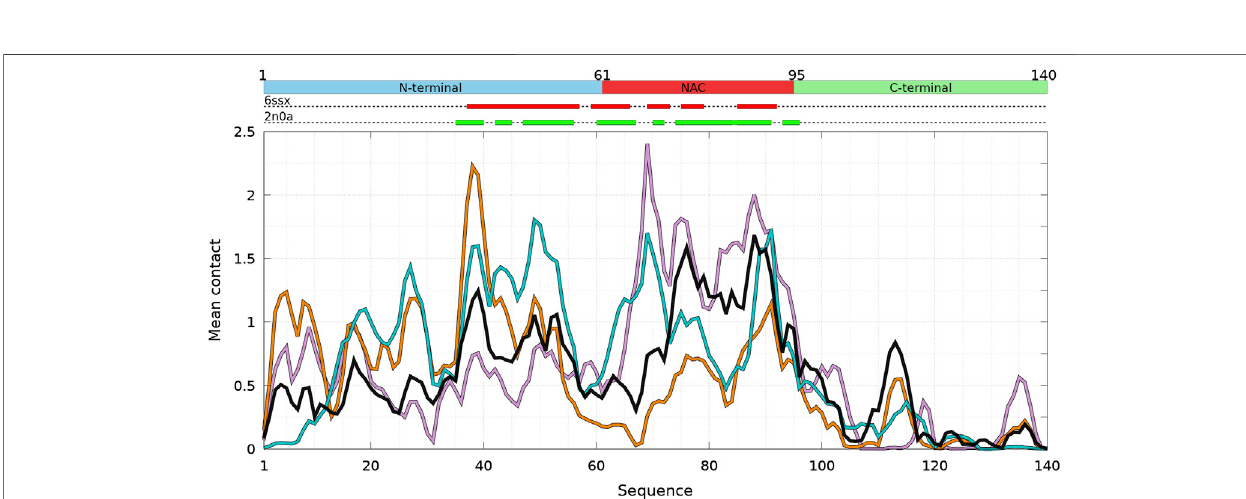
FIGURE 2 | Mean intermolecular contact of a residue of α -syn WT and mutants for the complete ensemble of dimers found in molecular dynamics trajectories at 300 and 310 K. The color code is black (WT), violet (A30P), orange (A53T), and turquoise (E46K). The upper bar represents the N-terminal (blue), NAC (red), and C-terminal (green) regions of the sequence. The red and green rectangles on the upper dotted bars describe the locations of the intermolecular β -sheets identi fi ed by CUTABI in the experimental structures of α -syn fi brils with the PDB IDs 6ssx and 2n0a, respectively.